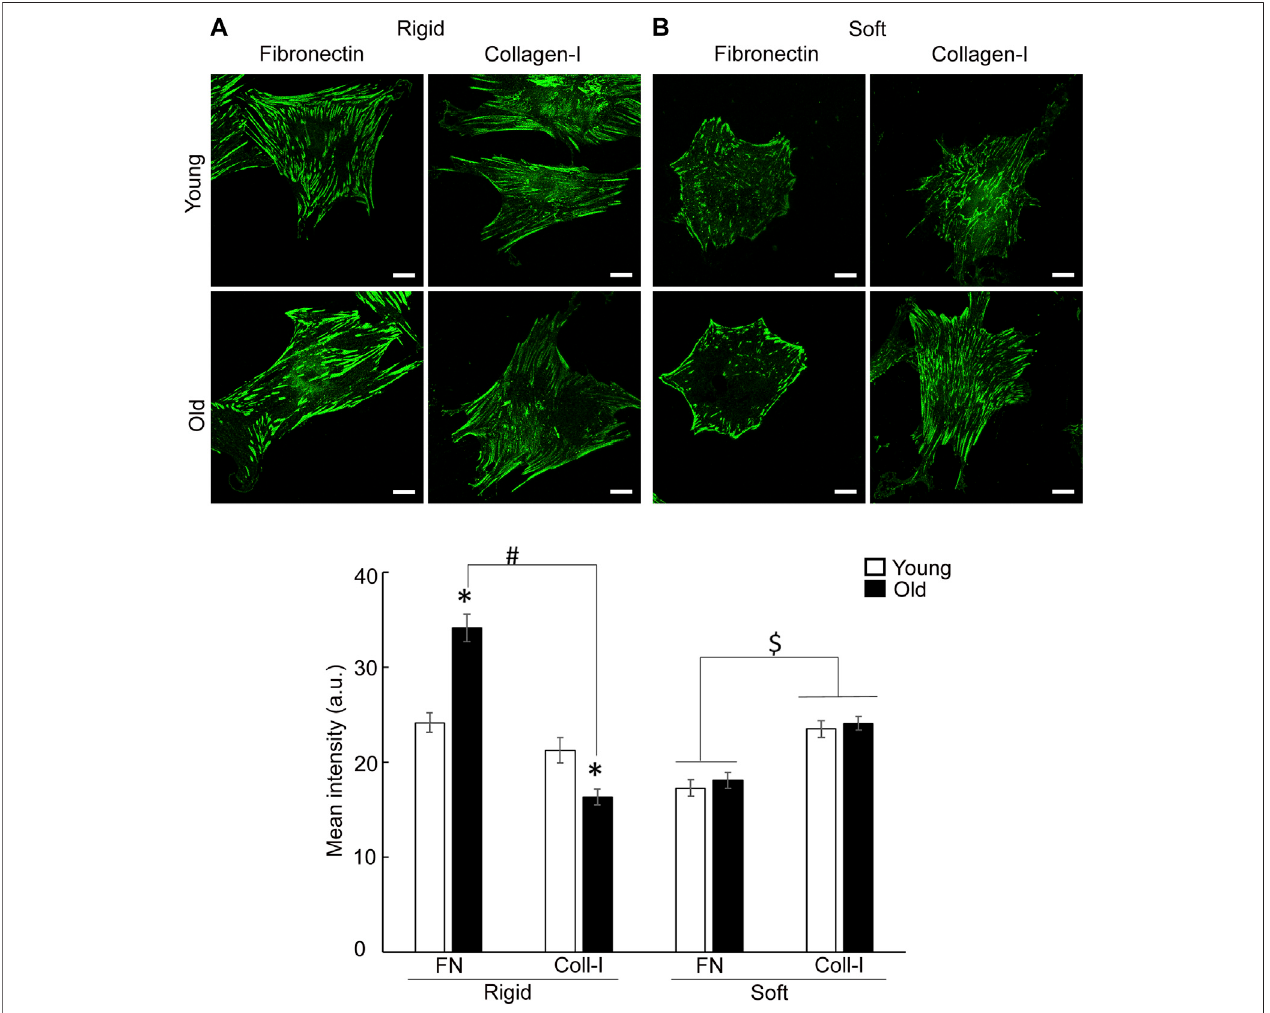
FIGURE 6 | Representative confocal images of VSM cells plated on (A) rigid and (B) soft substrates functionalized with fi bronectin and collagen-I, respectively, are shown. VSM cells have been fl uorescently labeled for integrin β 1. Scale bar represents 10 μ m. Quantitative measurements of overall fl uorescence intensity ( n = 28 – 68) are presented as mean ± SE. Signi fi cance was evaluated at p < 0.05. *Values are signi fi cantly different from young. # Values are signi fi cantly different from age matched VSM cells on different matrices. $ Values are signi fi cantly different between matrices.